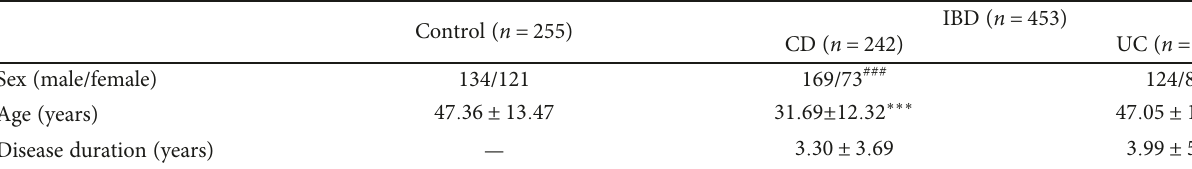
Table 1: Basic clinical features of IBD patients.